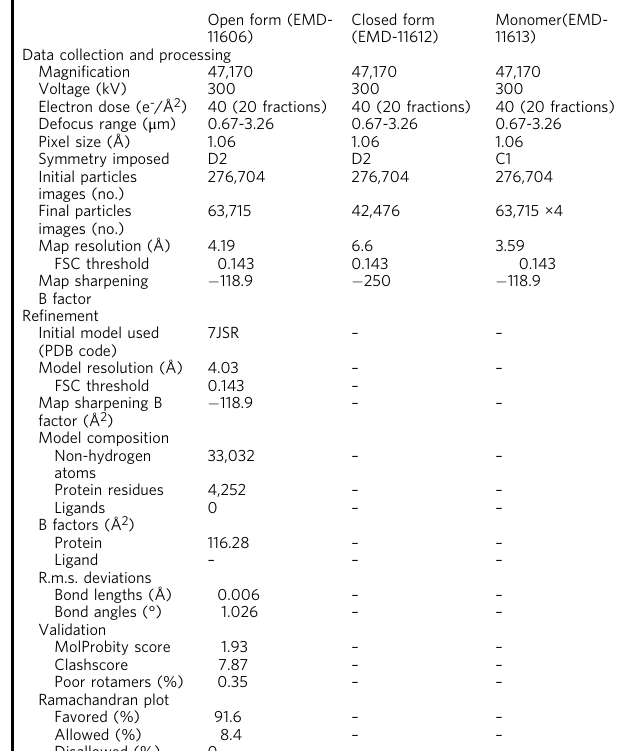
Table 1 X-ray diffraction data collection and re fi nement statistics.